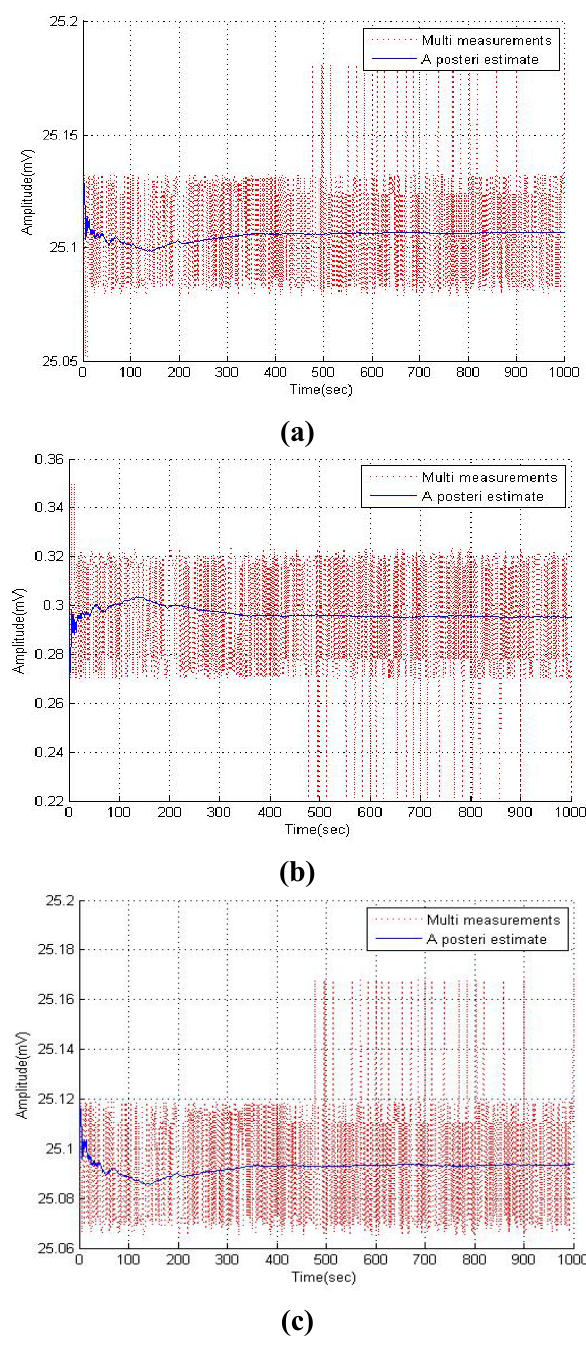
Figure 7. Simulation results of the improved Kalman filter. (a) Temperature sensor. (b) Humidity sensor. (c) Oxygen sensor.